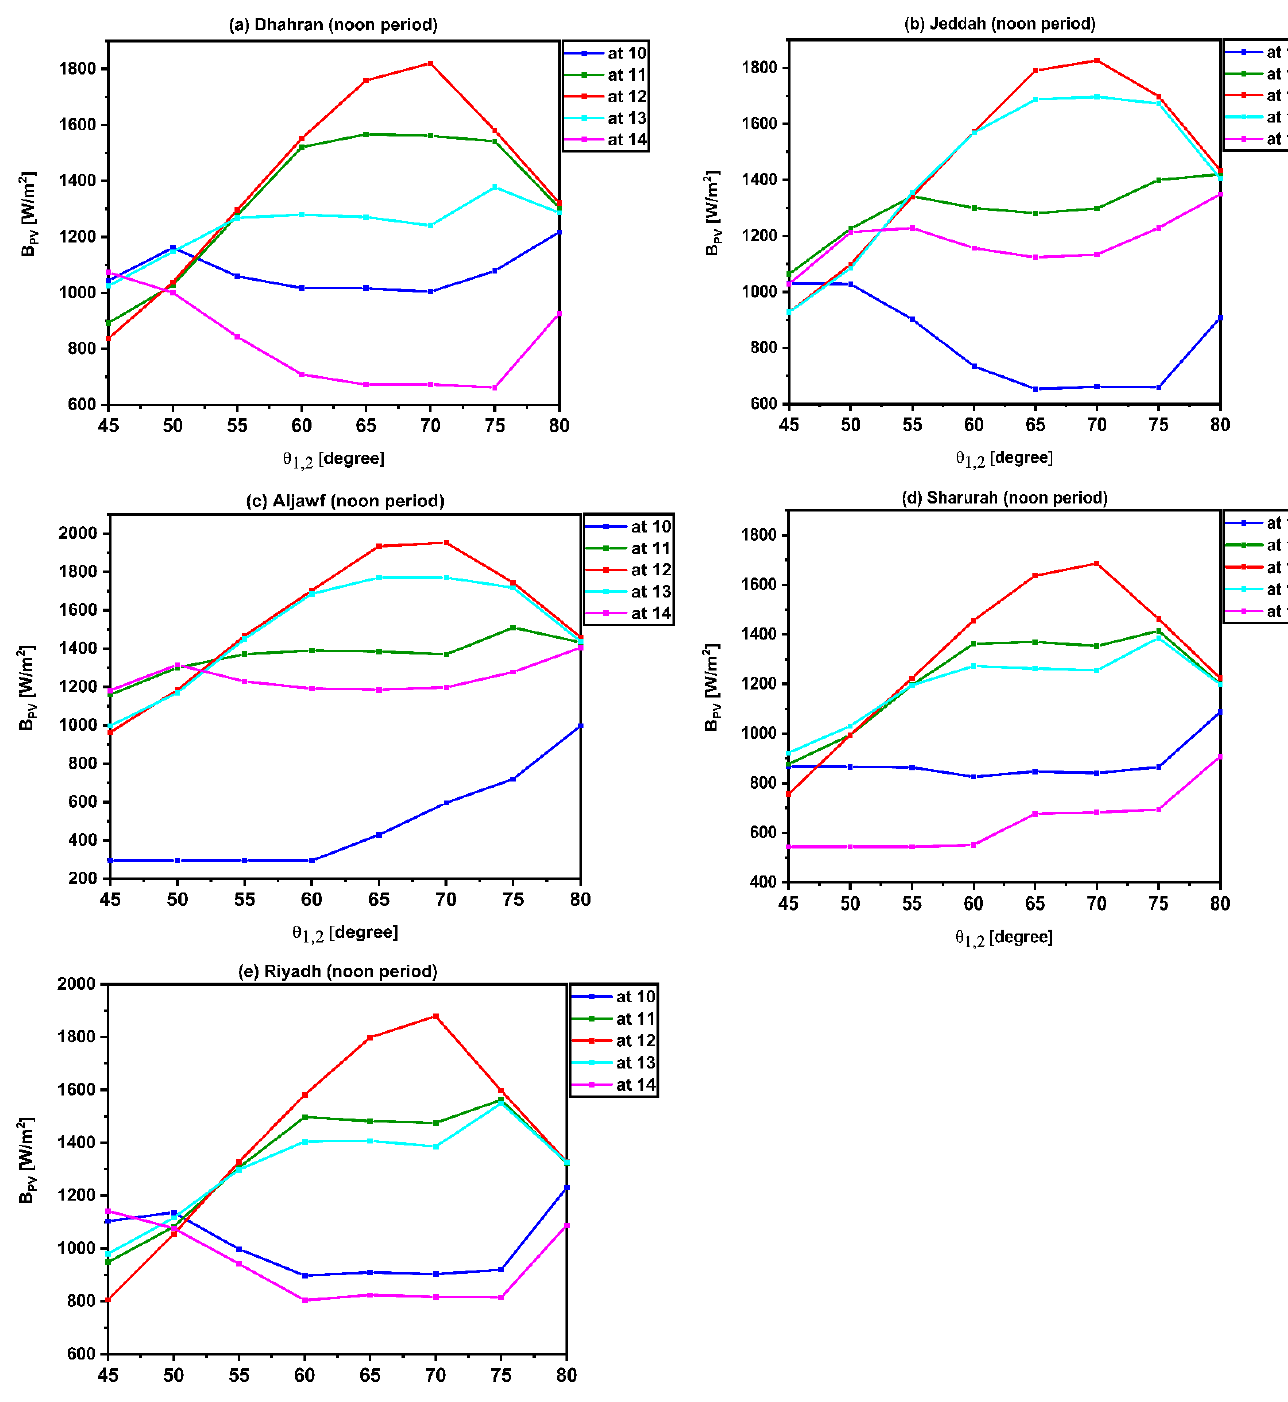
Figure 4. The irradiance B PV at different inclination angles in the case of double coverage for the solar time from 10:00 to 14:00 (θ 1 = θ 2 ) for the selected cities.